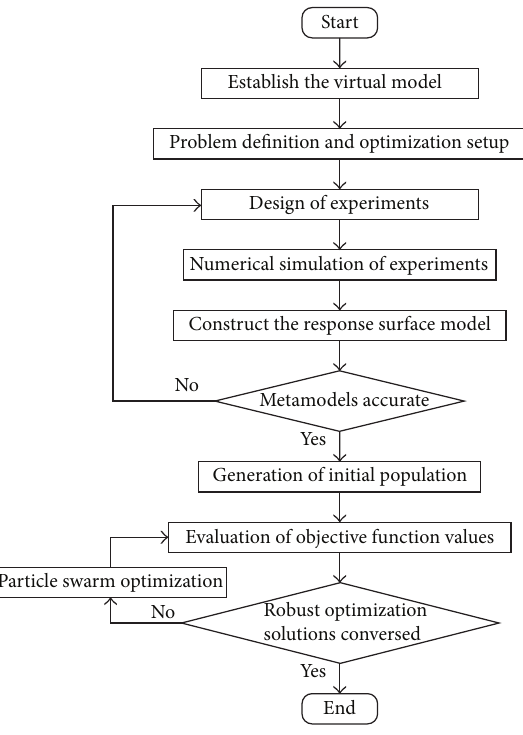
Figure 1: Robust design based on particle swarm